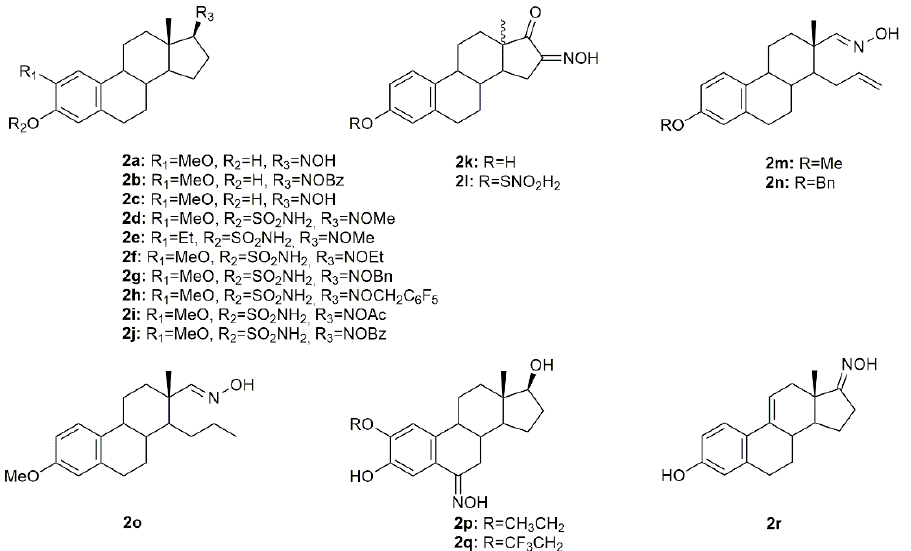
Figure 5. Steroidal estrane oxime derivatives with anticancer activity in several types of cancer cells. Table 2. IC 50 values (µM) of the synthesized estrane oxime derivatives.